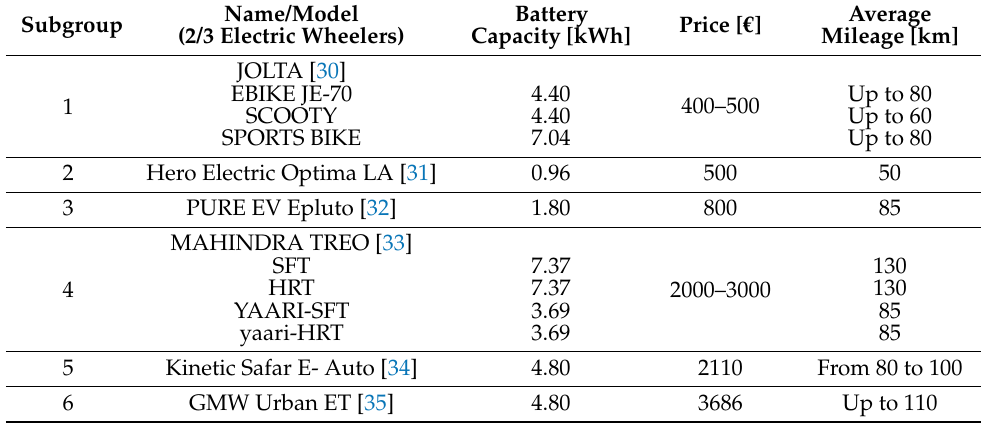
Table 1. Characteristics of 2/3 electric wheelers used in the ePop simulator.